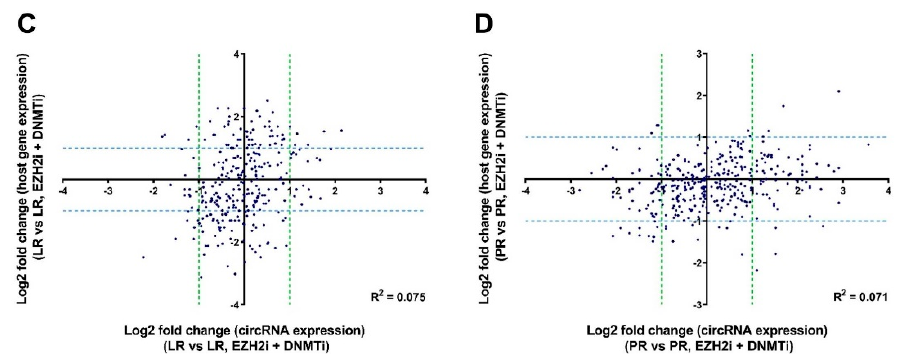
Figure 3. circRNA expression changes upon combined DNMT and EZH2 inhibition. ( A , B ) Waterfall plots illustrating the upregulated (in red) and downregulated (in blue) circRNAs in LR cells treated with DNMTi and EZH2i ( A ) and PR cells treated with DNMTi and EZH2i ( B ) relative to LR cells and PR cells, respectively. CircRNAs defined as high abundance in either LR cells, LR cells treated with DNMTi and EZH2i, PR cells, or PR cells treated with DNMTi and EZH2i, as shown in the Venn diagrams (left), were included in the analysis. ( C , D ) Scatter plots of log2 fold change in circRNA expression and log2 fold change in host gene expression in LR cells treated with DNMTi and EZH2i ( C ) and PR cells treated with DNMTi and EZH2i ( D ) compared to LR cells and PR cells, respectively. Potential correlations were assessed by calculating Pearson correlation coefficients, R 2 . LR, lenalidomide-resistant, PR, pomalidomide-resistant.